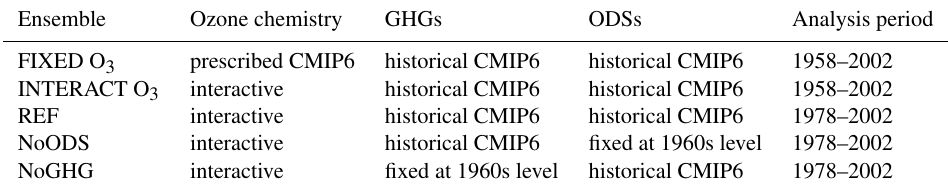
Table 1. Overview of the FOCI ensembles used in this study. Each ensemble consists of three simulations that vary in their initial conditions. Ensemble Ozone chemistry GHGs